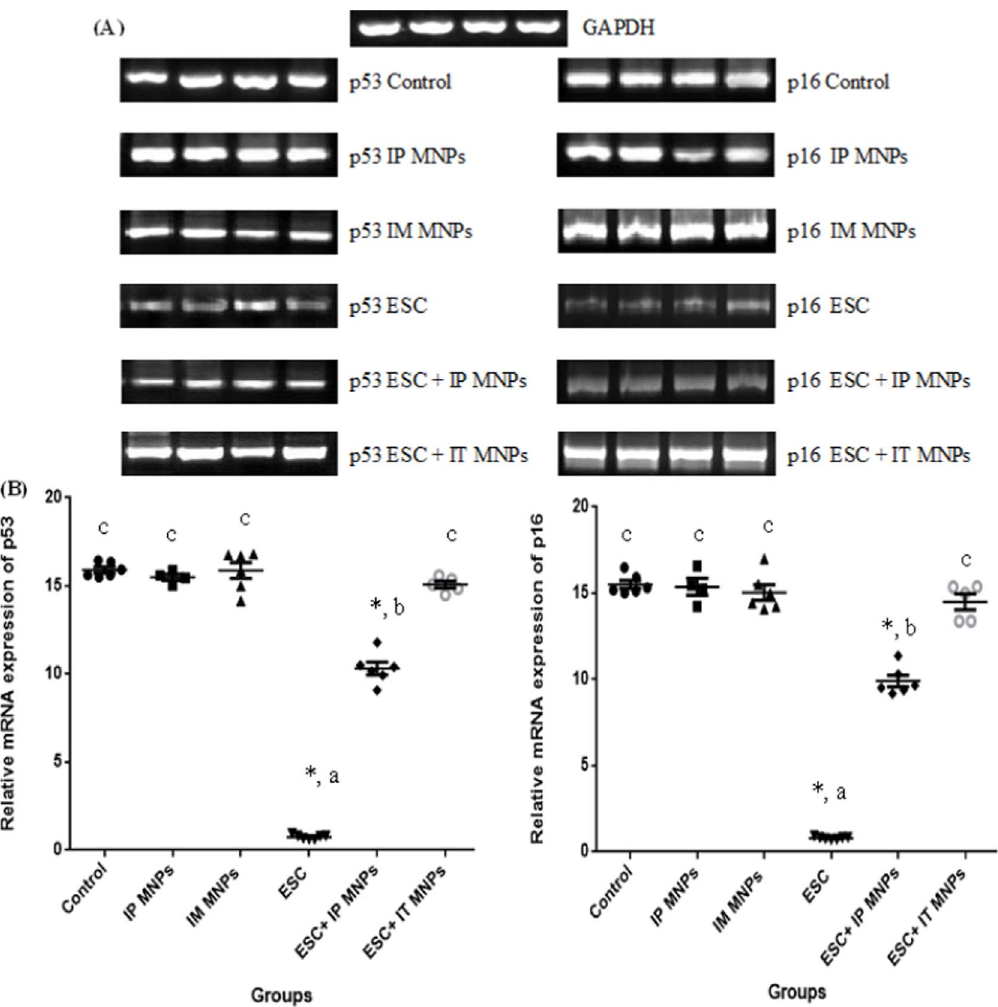
Figure 8. Comparison of effect of MNPs on the expression of p53 and p16 mRNA in ESC and skeletal muscles in our different six groups of mice. (A) Semiquantitative RT-PCR to amplify p53 (left), p16 (right) and GAPDH genes. Representative images are shown. (B) Real time PCR was performed to amplify p53 (left), p16 (right) and GAPDH genes. The mRNA ratios of p53 and p16 to GAPDH were calculated using the DD Ct method. Each bar represents mean 6 SE of six independent experiment. Asterisks indicate statistically significant differences between this group and the control group ( p , 0.05). Both methods show that MNPs increases the expression level of p53 and p16 mRNA in Ehrlich tumor treated IP (group 5) and IT (group 6). Primers described in Table 1. - The same letter means that there is no significant difference between the two groups by using Duncan multiple comparison test (P . 0.05). - The different letters means that there is a significant difference between the two groups by using Duncan multiple comparison test (P , 0.05). - Asterisks indicate statistically significant compared with negative control using student t-